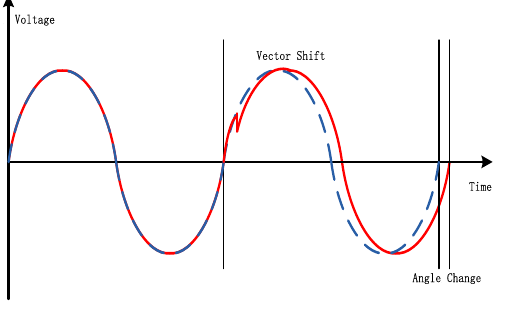
Figure 2. Transient voltage change.